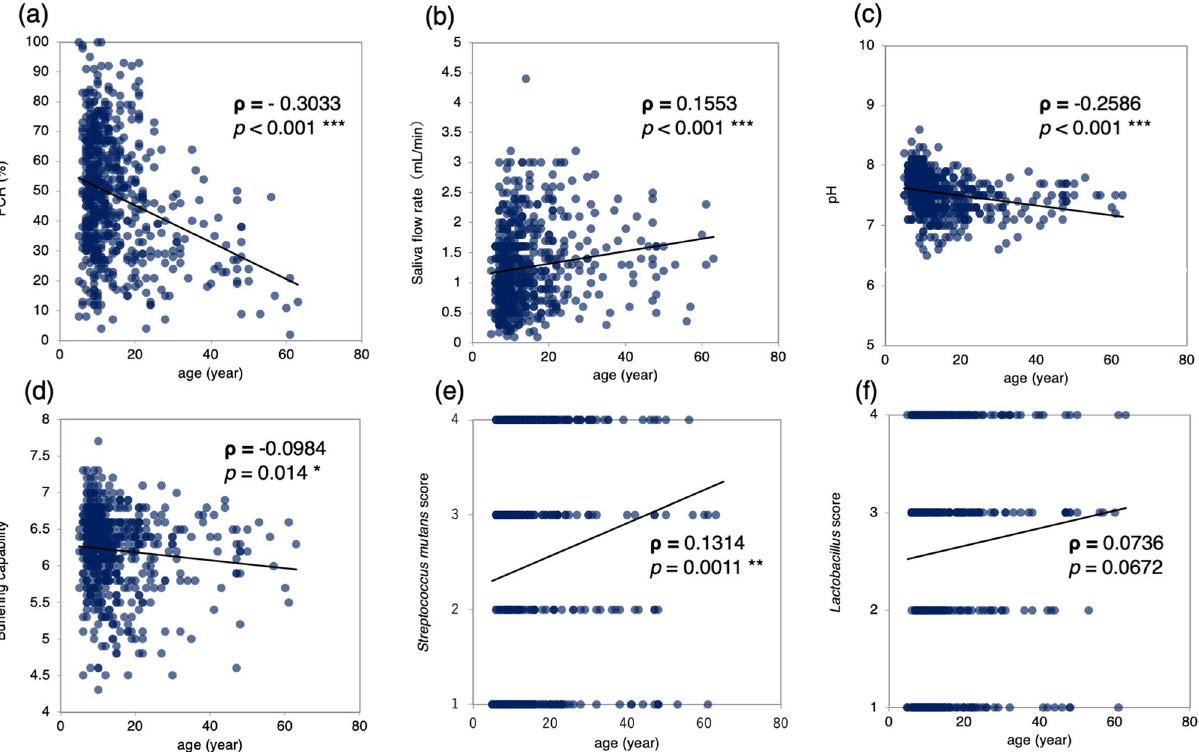
Figure 2. Correlation with age. Correlation between the scores of ( a ) PCR, ( b ) Saliva flow rate, ( c ) pH, ( d ) Buffering capability, ( e ) Streptococcus mutans score, and ( f ) Lactobacillus spp. score and subject’s age using the Spearman’s rank correlation coefficient. Each dot represents a subject, and the linear regression is shown by a solid line. The values of the correlation coefficient are shown as (ρ) and significant differences are indicated as * p < 0.05, ** p < 0.01 and *** p < 0.001. PCR, plaque control